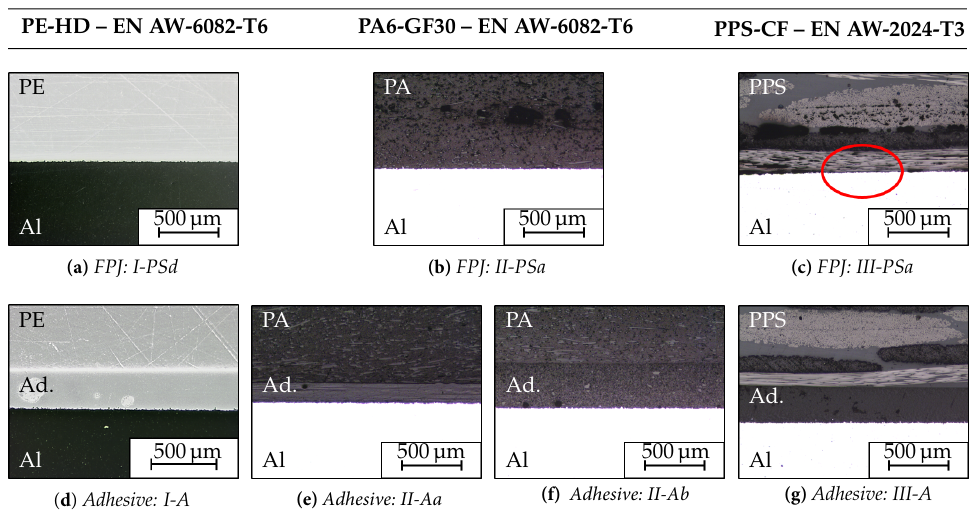
Figure 8. Cross-sections of the joining zones for the three considered material combinations and the two joining processes; the captions of the individual images refer to the process parameters used or the applied adhesive. To achieve a better visibility of the layered structure, the contrast of the microscopic images was increased, which causes a side effect: the aluminum appears black ( a , d ) or white. The adhesive layer is indicated as Ad .